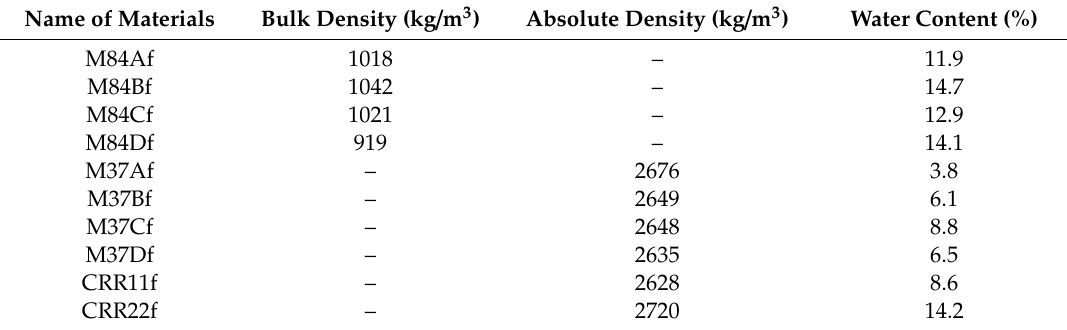
Table 4. Physical properties of di ff erent